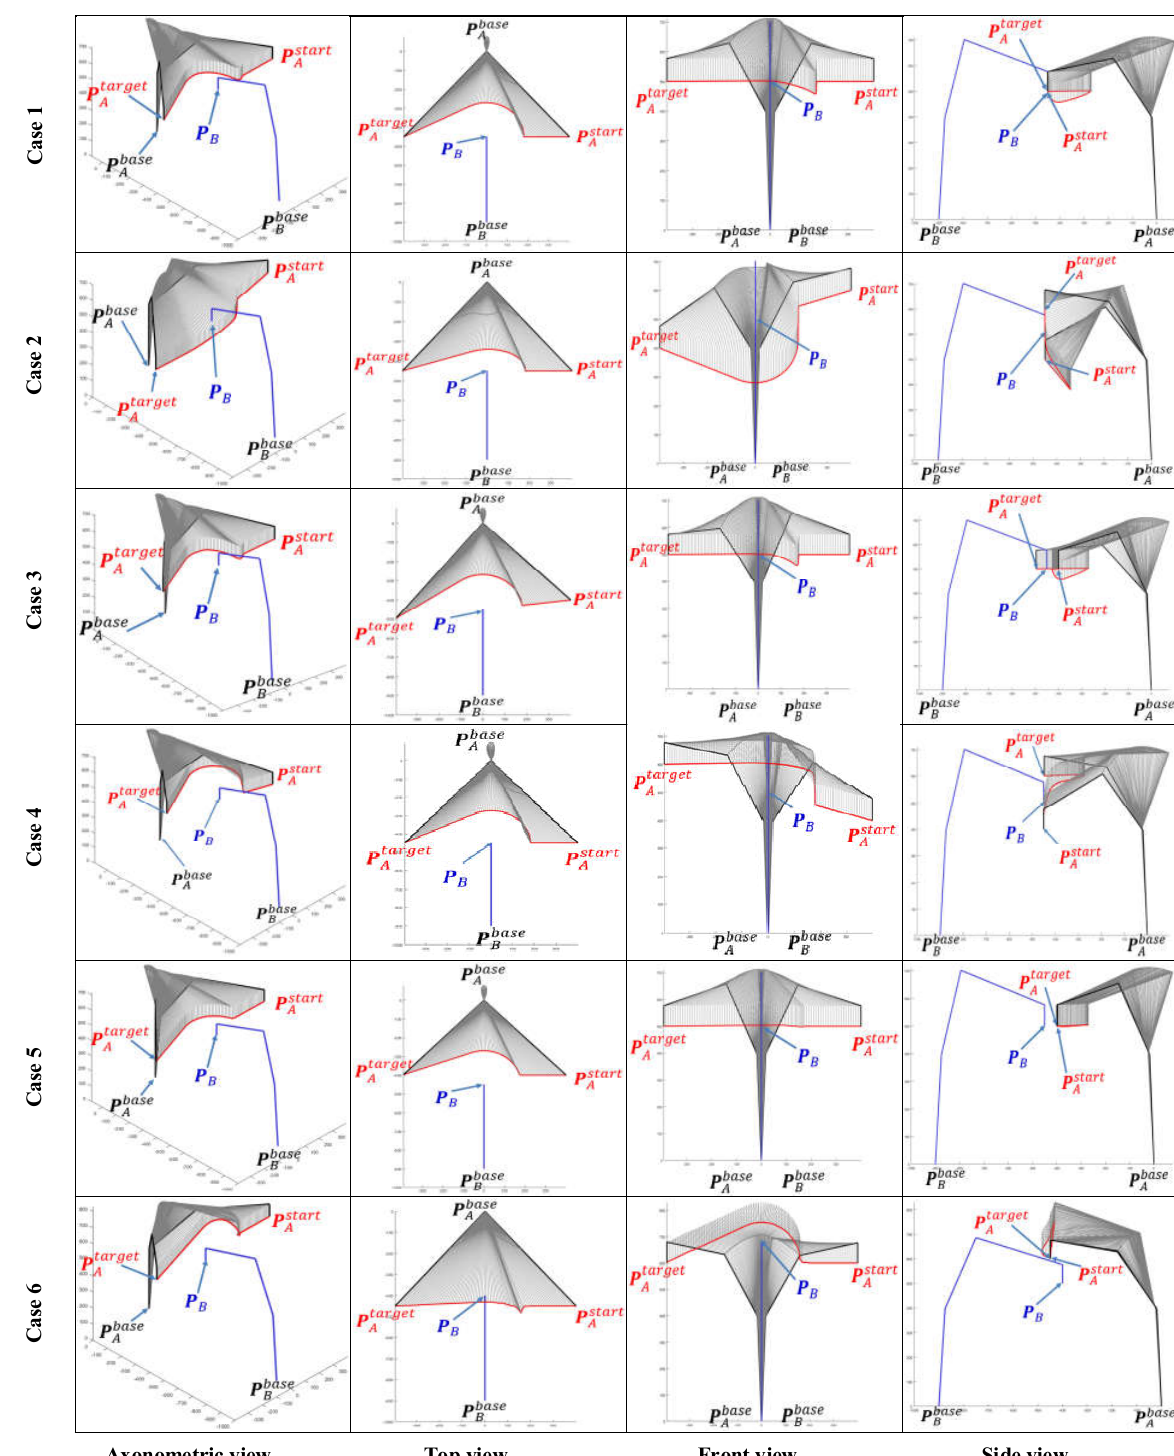
Figure 9. Comparison of single manipulator avoidance simulation results. Compared to Figures 7 and 8, the six cases in this diagram merely modify the end-effector pose vectors of the manipulators, whilst the simulation results obtained are significantly distinctive.